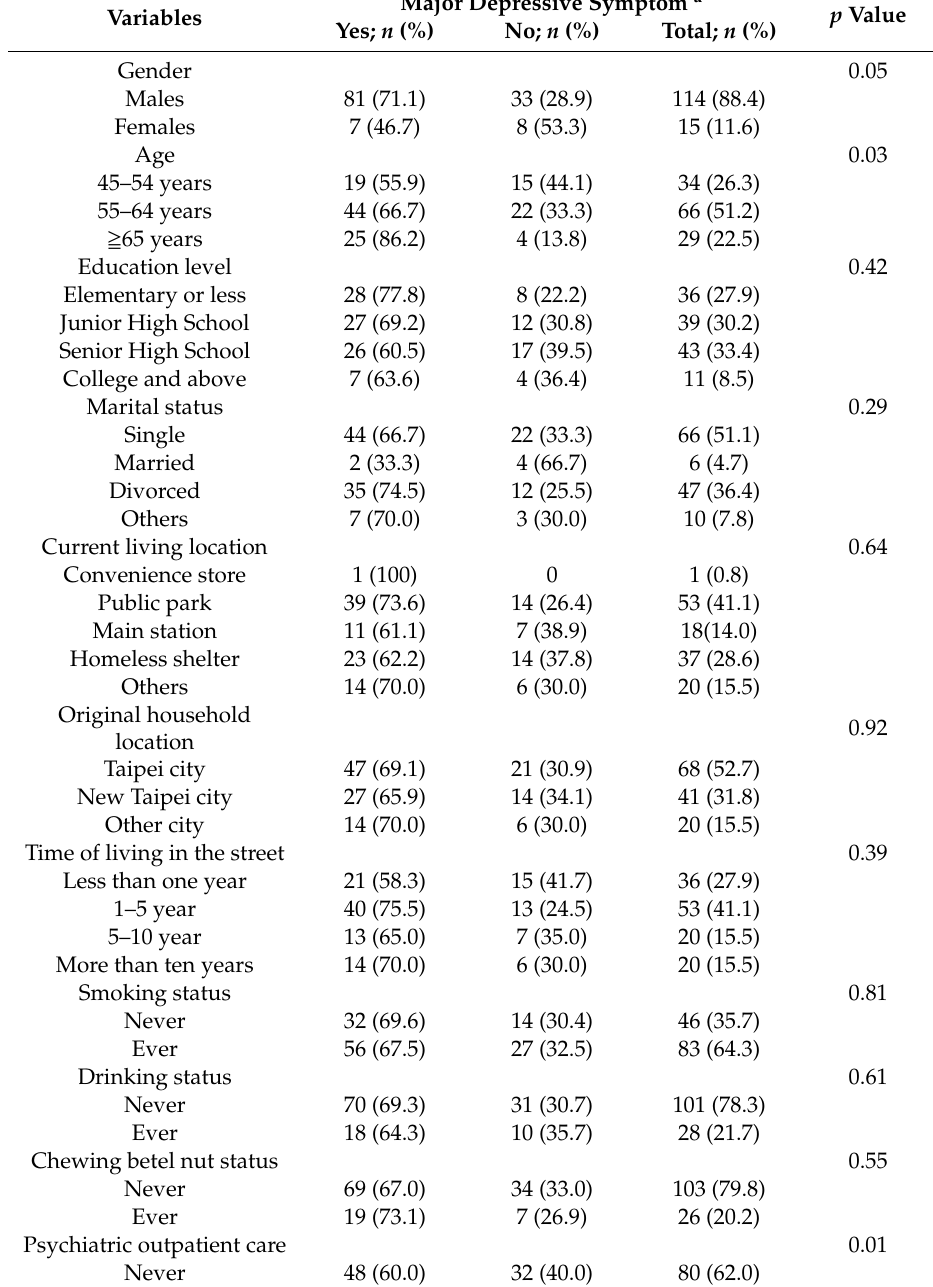
Table 4. Relation of homeless people characteristics and major depressive symptoms (chi-square